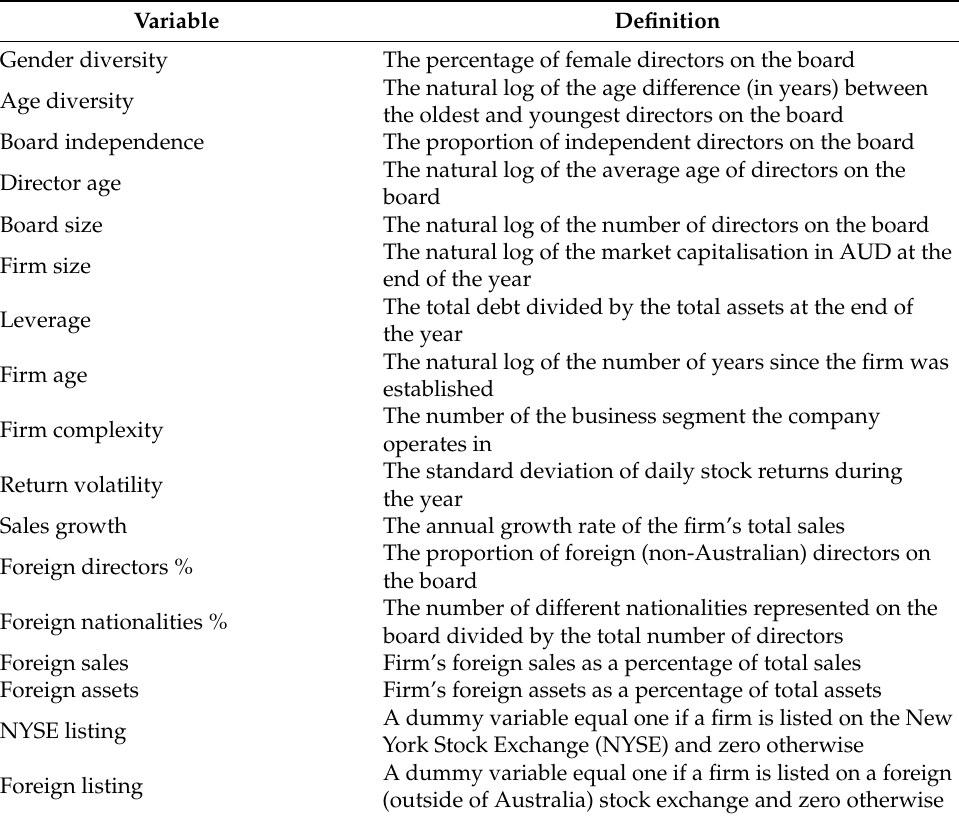
Table A2. Variables